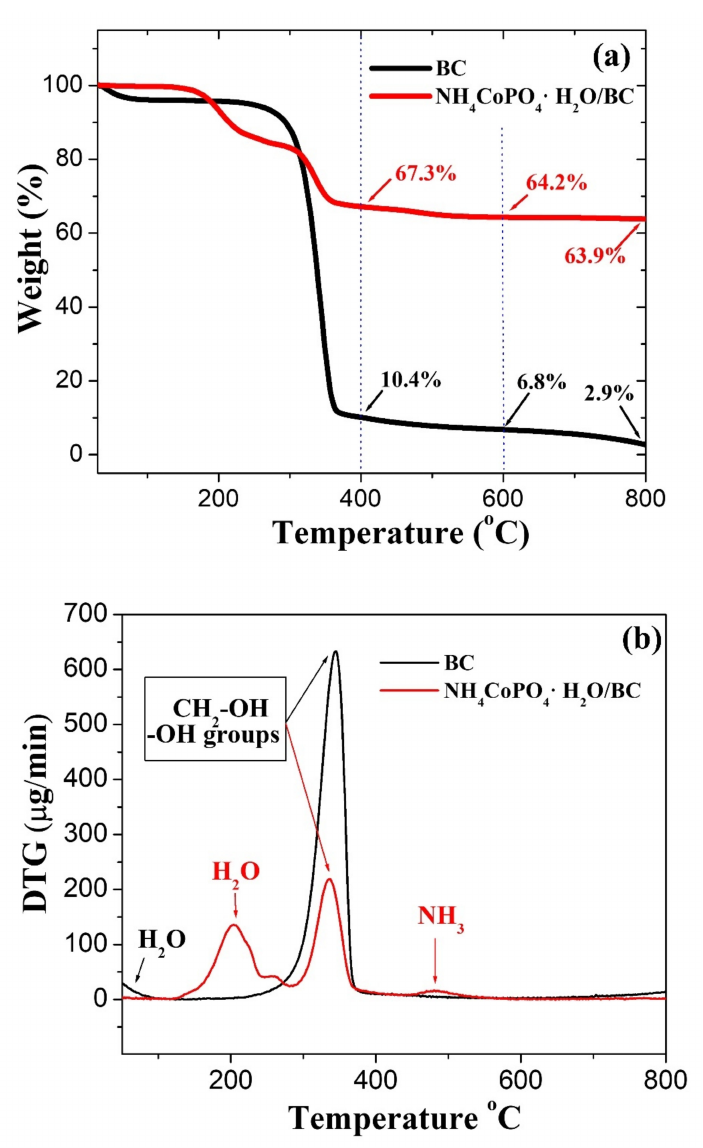
Figure 3. ( a ) TGA and ( b ) DTG curves of NH 4 CoPO 4 · H 2 O/BC and